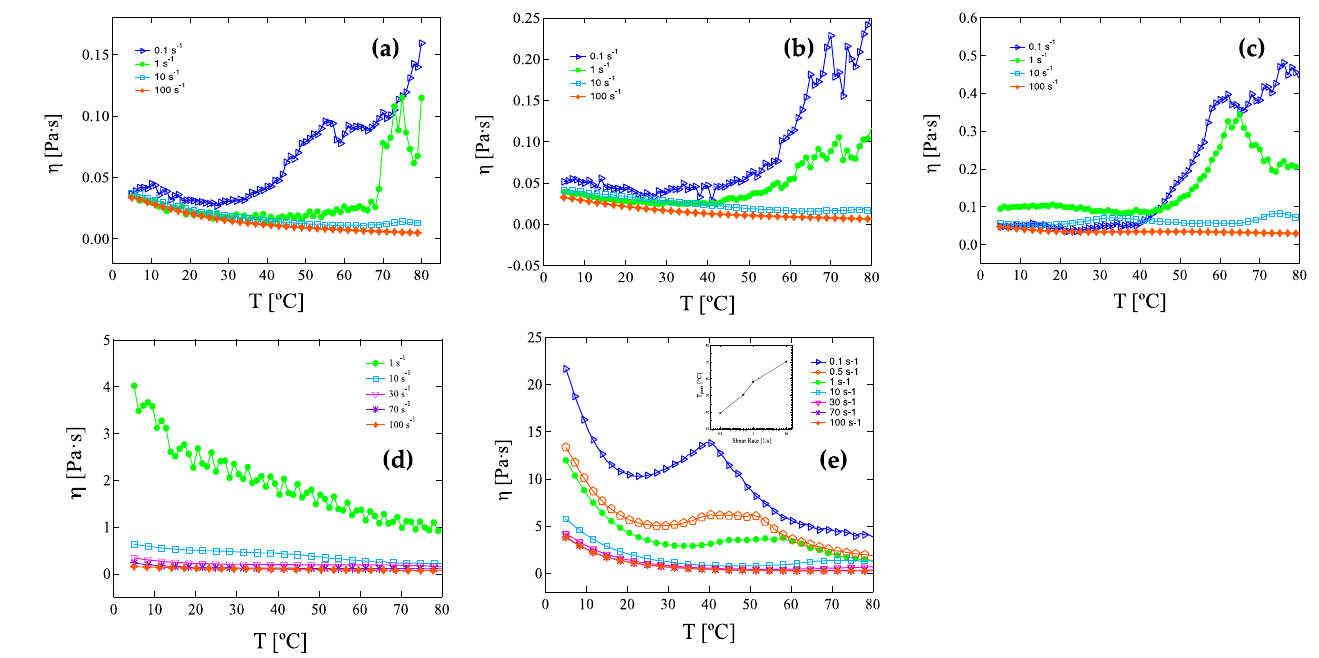
Figure 5 . Steady temperature ramp measurements at 1 °C/min heating rate on inks and pastes with HRCM loads of ( a ) 0.08, ( b ) 0.16, ( c ) 0.40, ( d ) 0.80, and ( e ) 2.40 wt%. Inset of Figure 5e: Temperature at the observed shear viscosity peak as a function of the applied shear rate.